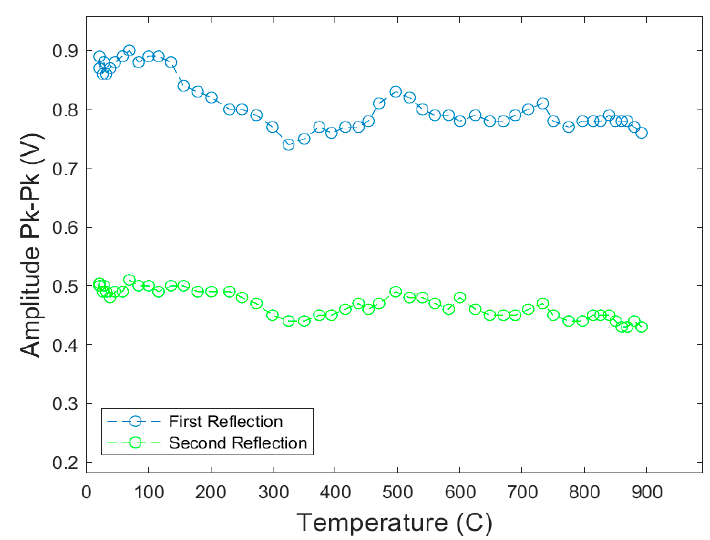
Figure 14. Signal amplitude (peak-to-peak) for the first two reflections as a function of temperature for bismuth titanate thick-film, spray-on transducer [7].